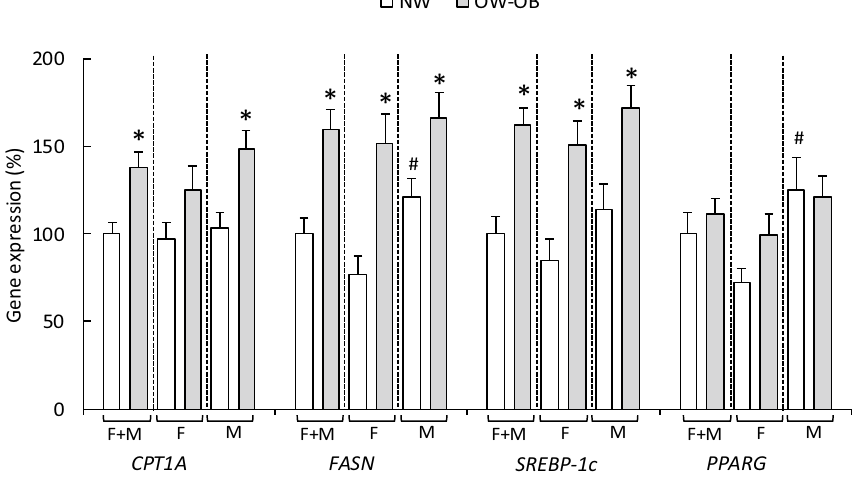
Figure 1. Expression of lipid metabolism genes in PBMC from NW and OW-OB subjects and stratified by sex in each of the groups. Data are mean ± SEM (n = 20 in the NW and n = 27 in the OW-OB group) and are expressed as a percentage of the mean value of the NW group. Statistics: *OW-OB vs NW; # NW men vs NW woman, and OW-OB men vs OW-OB woman (p < 0.05, Student’s t test; two tailed; unpaired samples).